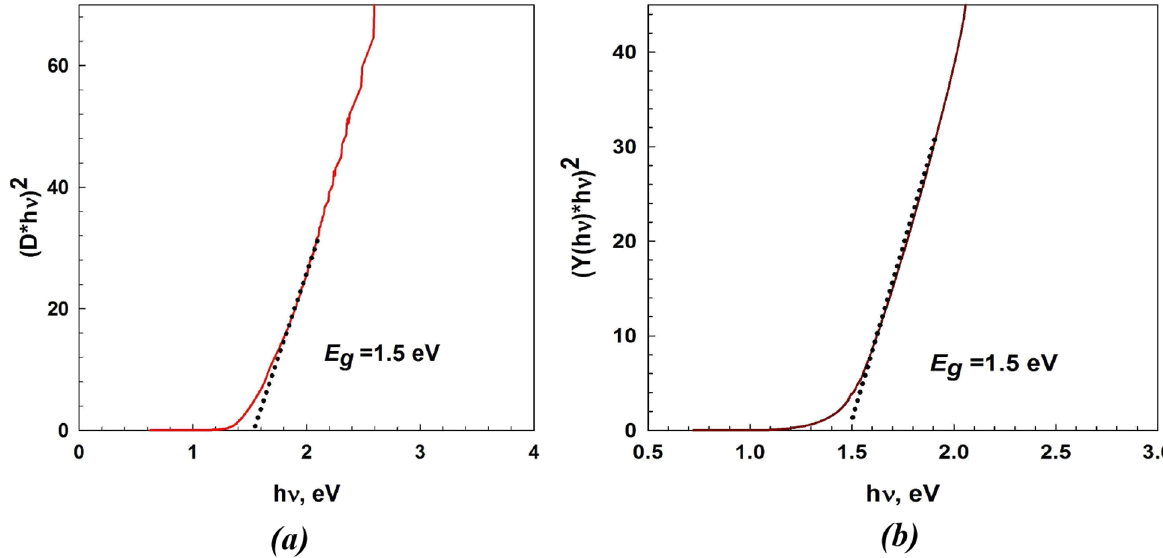
Fig. 4. The determination of band gap energy according to absorption spectra (a) and re fl ection spectra (b) of CZTS thin fi lms.